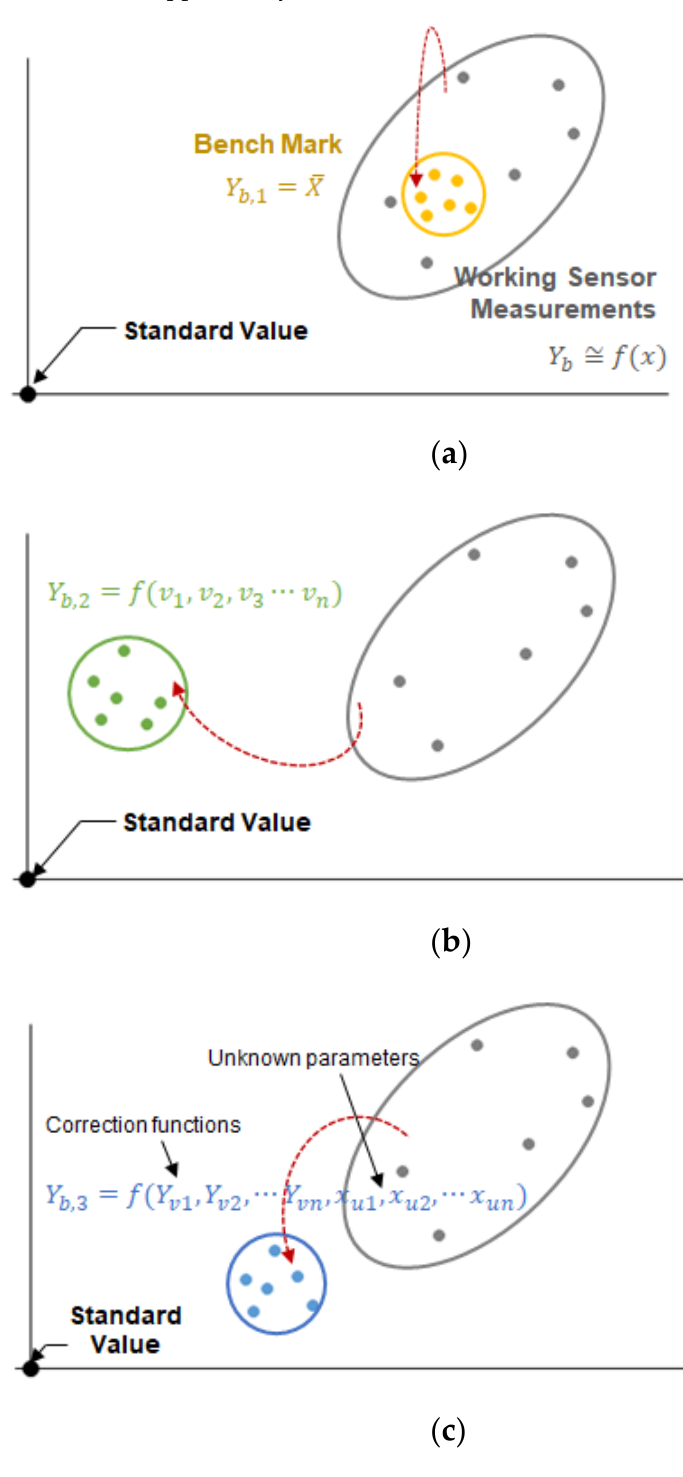
Figure 7. Sensor calibration method. ( a ) Statistics model based. ( b ) Mathmatical model based sensor calibration. ( c ) Bayesian statistic model